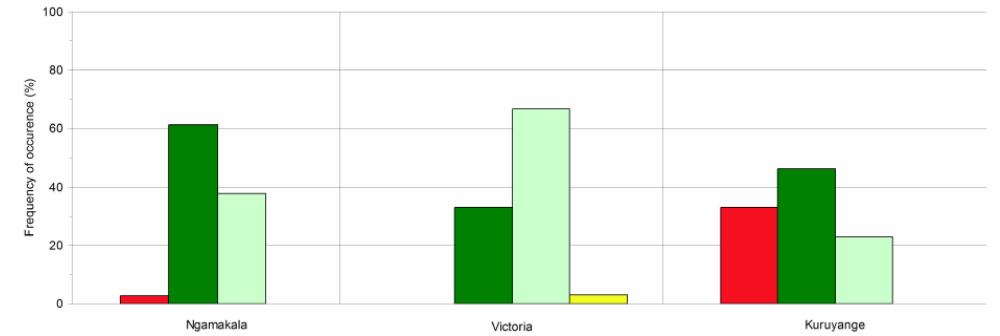
Fig. 4. Frequency of occurence within the total number of simulations of the biome types simulated for each site. In red, Tropical Evergreen Forest biome; In dark green, Tropical Semi-Deciduous Forest biome; In light green, Tropical Deciduous Forest/Woodland biome; In yellow, Tropical Savanna.